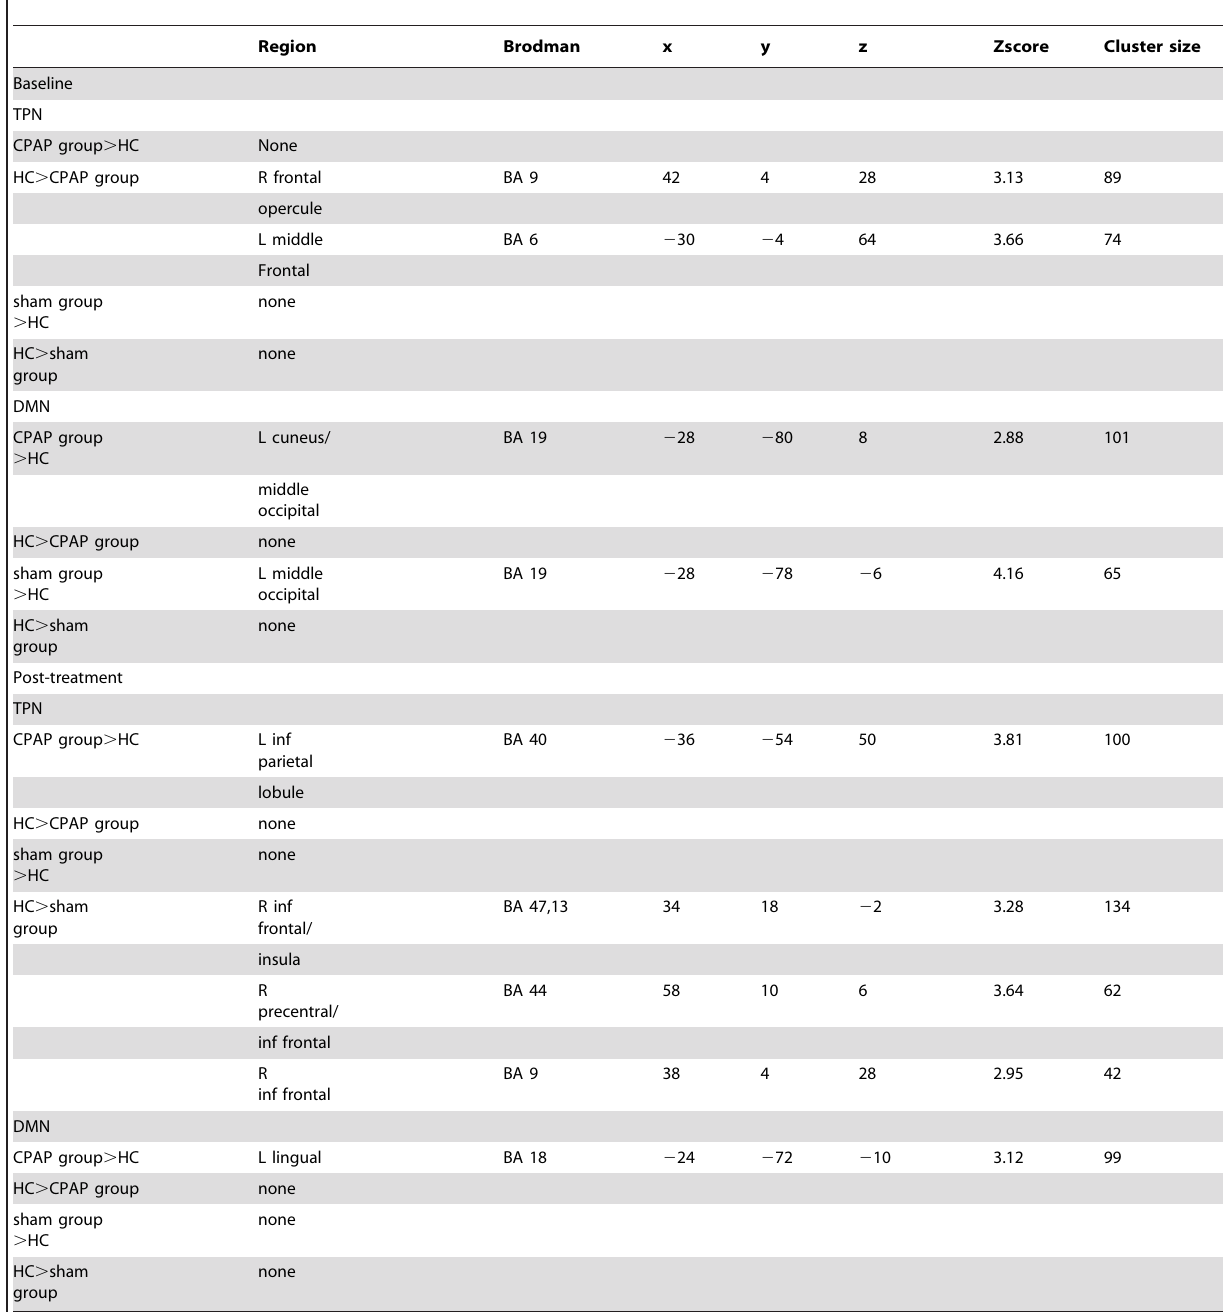
Table 4. CPAP and sham-CPAP groups compared to HC: cerebral regions showing significant task-related activation and deactivation in TPN and DMN regions in 1vs0, 2vs0 and 3vs0 contrasts in active and sham-CPAP patient’ groups as compared to HC (MNI coordinates, corrected for multiple comparisons, p